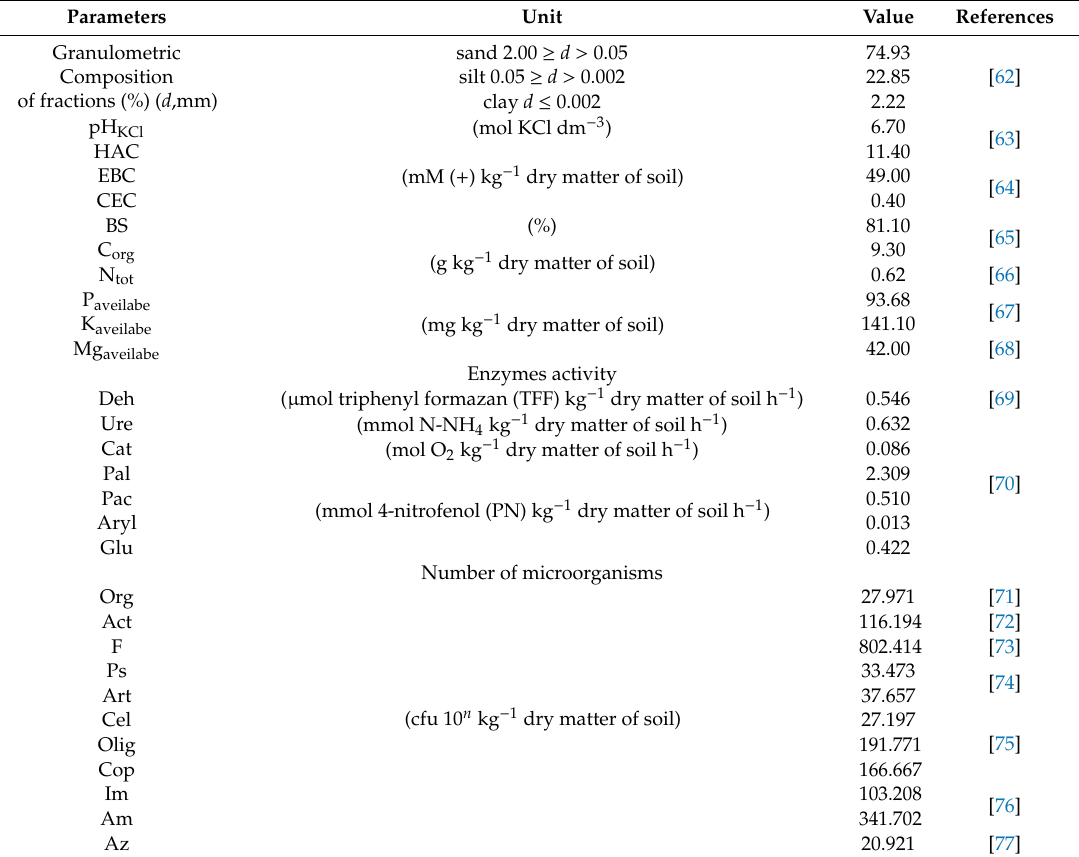
Table 1. Soil characteristic (physicochemical, chemical, biochemical and microbiological properties). Parameters Unit